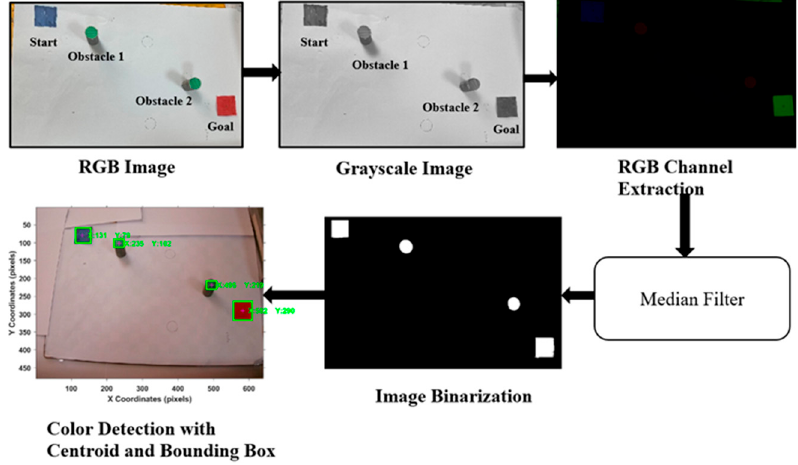
Figure 2. ( a ) Pattern Centric View of Eye-to-Hand Calibration ( b ) Camera Centric View of Eye-to- Hand Calibration .